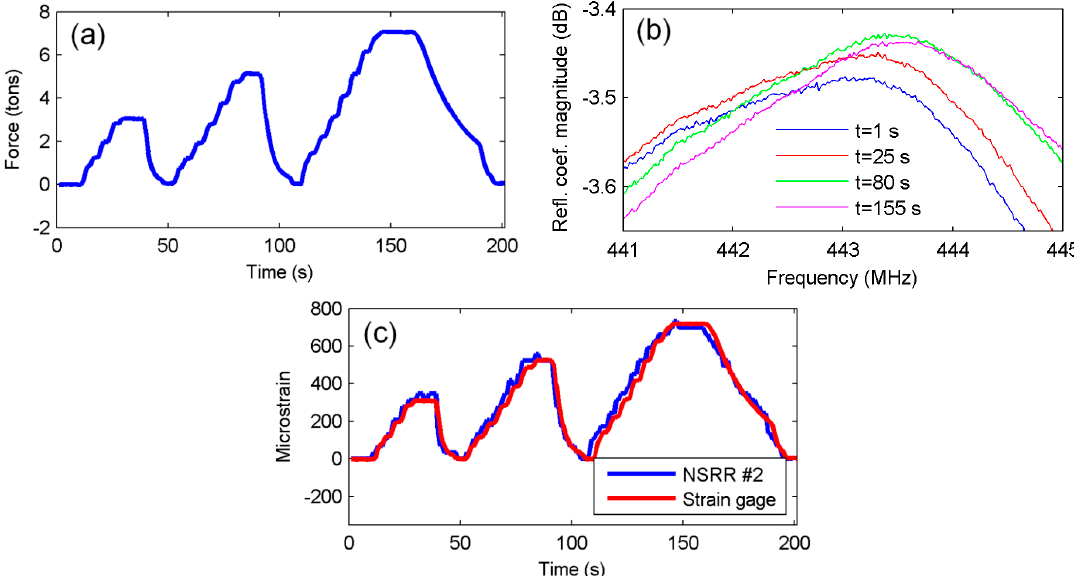
Figure 5. Elastic deformation region experiment results of NSRR #2: ( a ) applied vertical force read from the load cell; ( b ) NSRR #2 resonance frequency peaks with strain forming due to applied load at several time instants; and ( c ) strain obtained from NSRR #2 plotted versus time, and compared to the data from the strain gages.